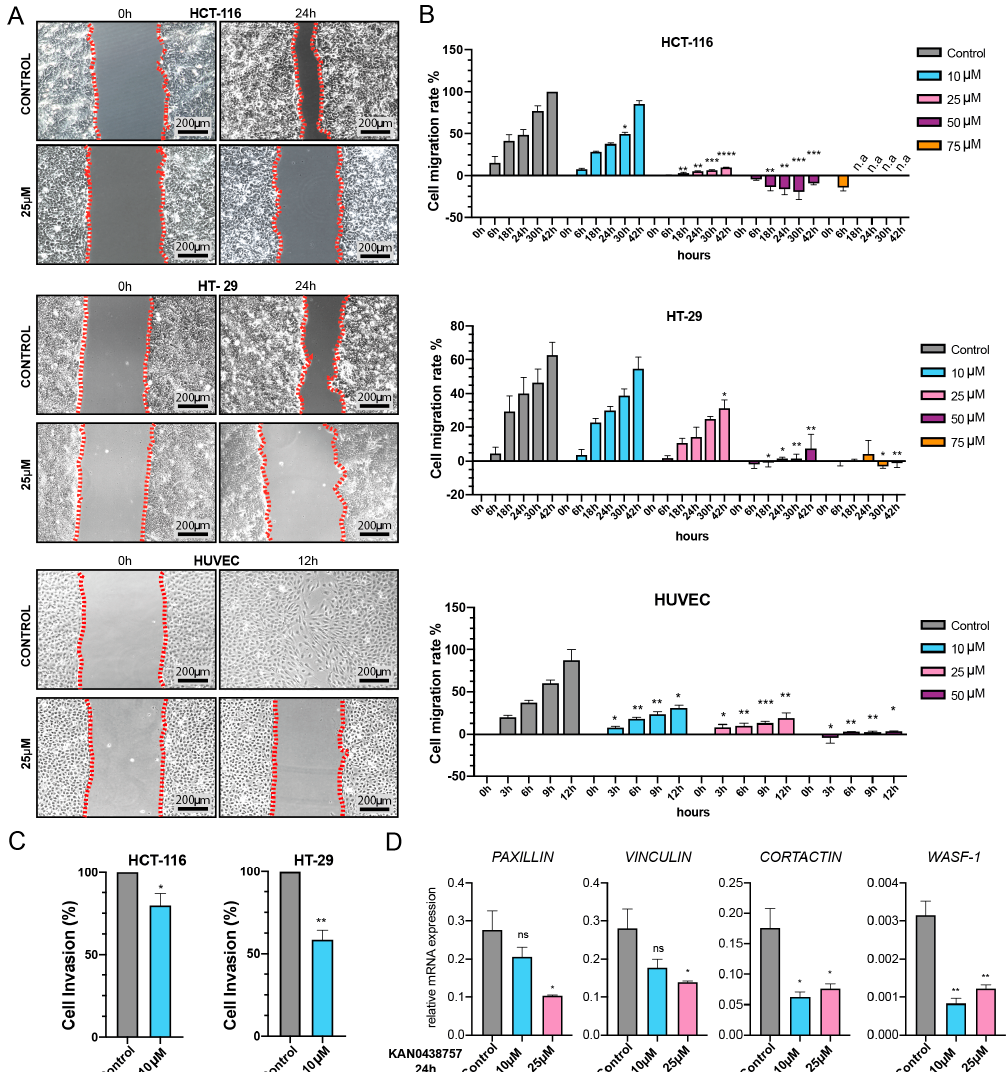
Figure 6. PFKFB3 inhibition by KAN0438757 alters cell motility and cancer cell invasion capabilities. ( A ) Representative pictures of migration assay performed with 25 μ M KAN0438757. ( B ) Migration assay quantification performed with HCT-116, HT-29 and HUVEC cells under different concentrations of KAN0438757 for 42 h (cancer cells) and 12 h HUVEC cells. ( C ) Boyden chamber invasion assay quantification performed with HCT-116 and HT-29 cancer cells for 96 h. ( D ) RT-PCR analysis for cell migration-and cytoskeleton-associated genes in HUVECs. Data is ± SEM. ( B , C ) combined data from three independent experiments. ( D ) data is representative for three independent experiments. * p < 0.05; ** p < 0.01; *** p < 0.001; **** p < 0.0001; ns, p > 0.05 .